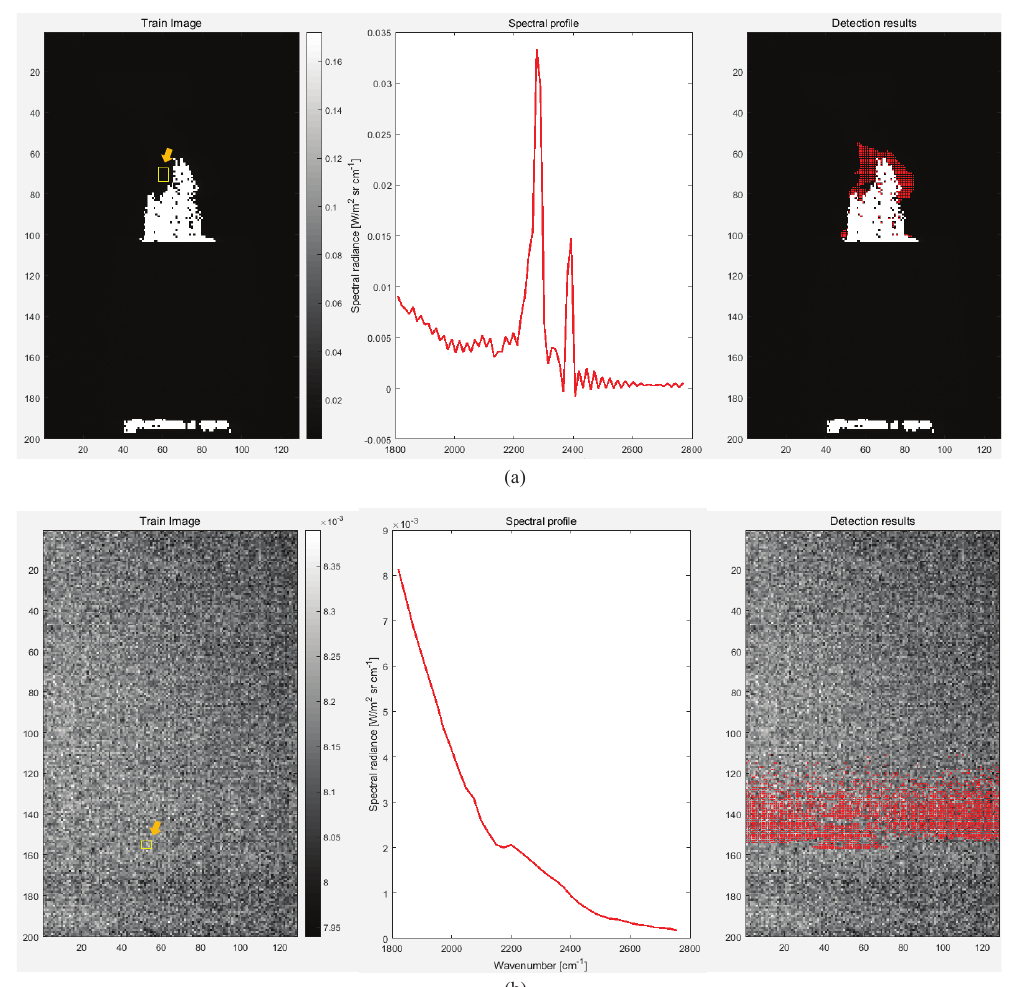
Figure 10. Spectral profile-based target detection results: ( a ) near CO 2 , ( b ) remote CO 2